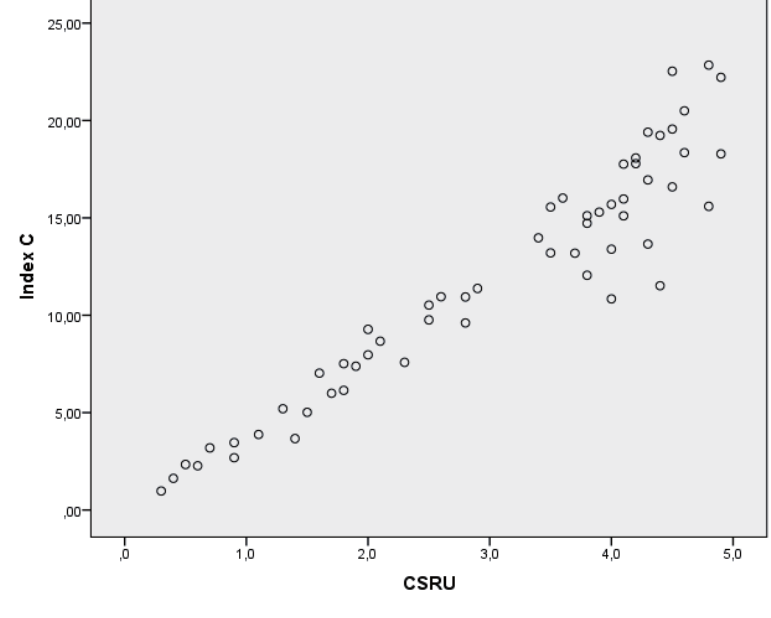
Fig. 1 – Scatter plot. Source: own, IBM